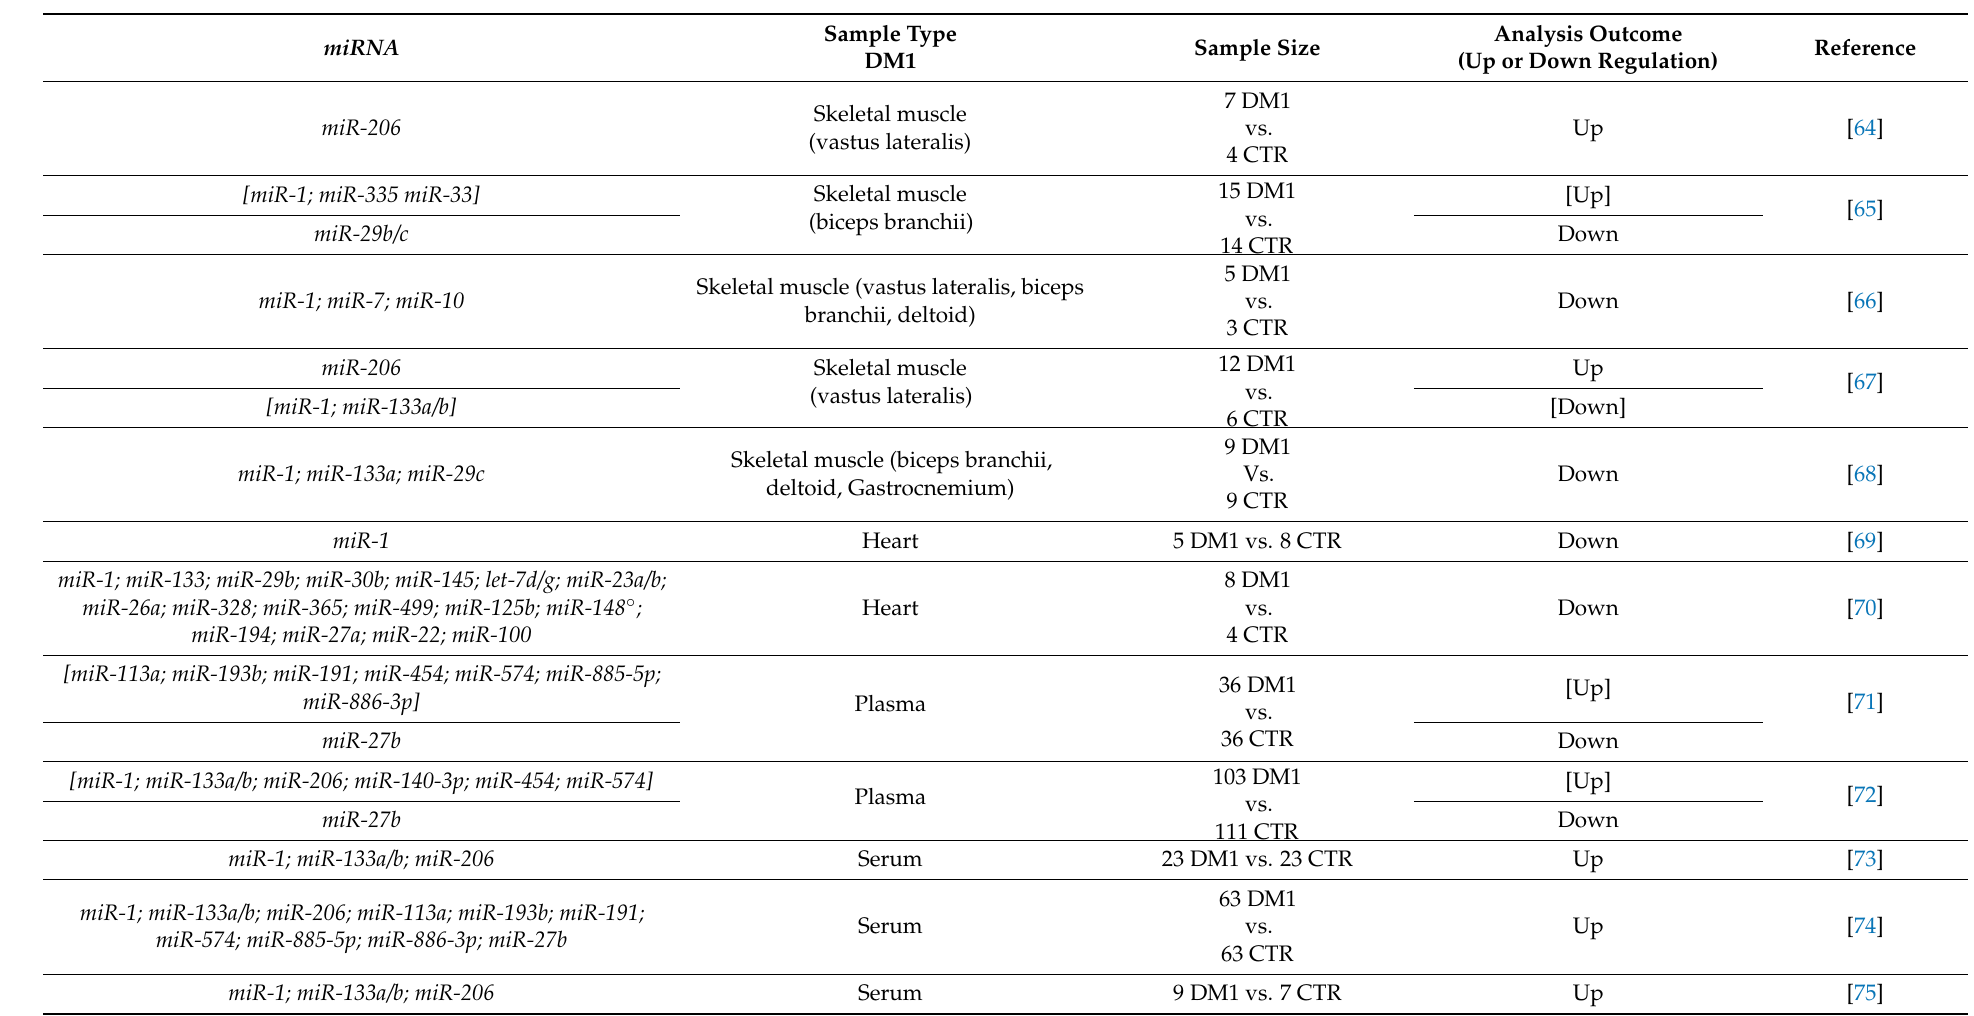
Table 2. Deregulated miRNAs in different biological samples from DM1 and DM2